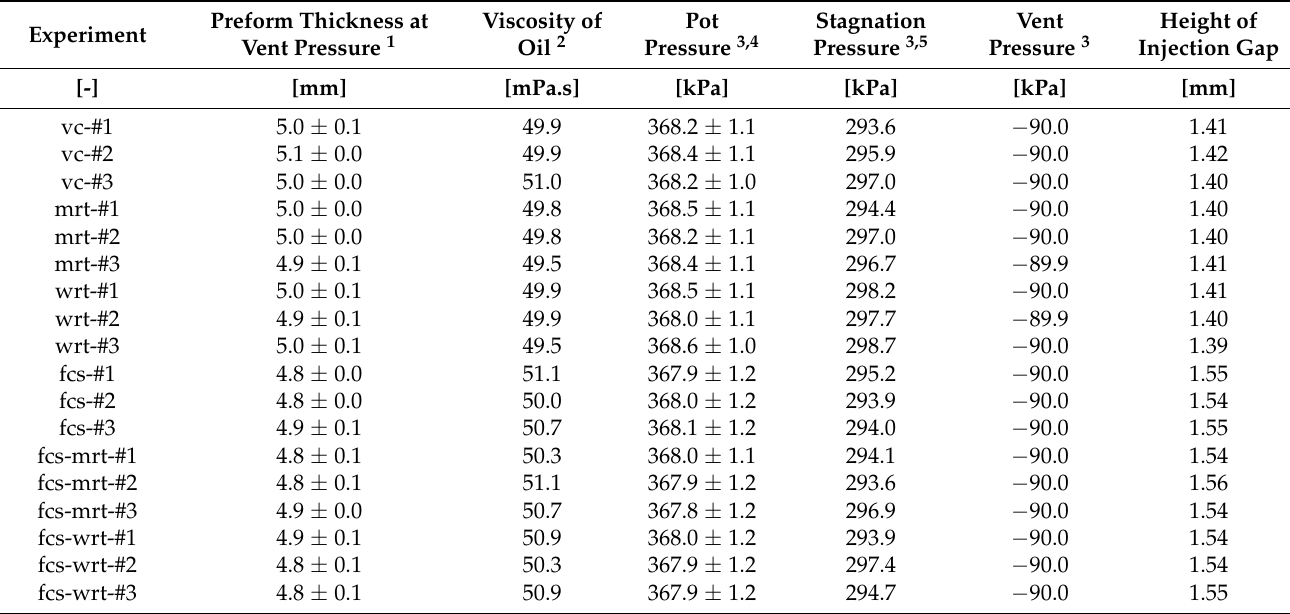
Figure A2. Features and components of a film-sealed preform package. Table A3. Process factors of the presented experiments.